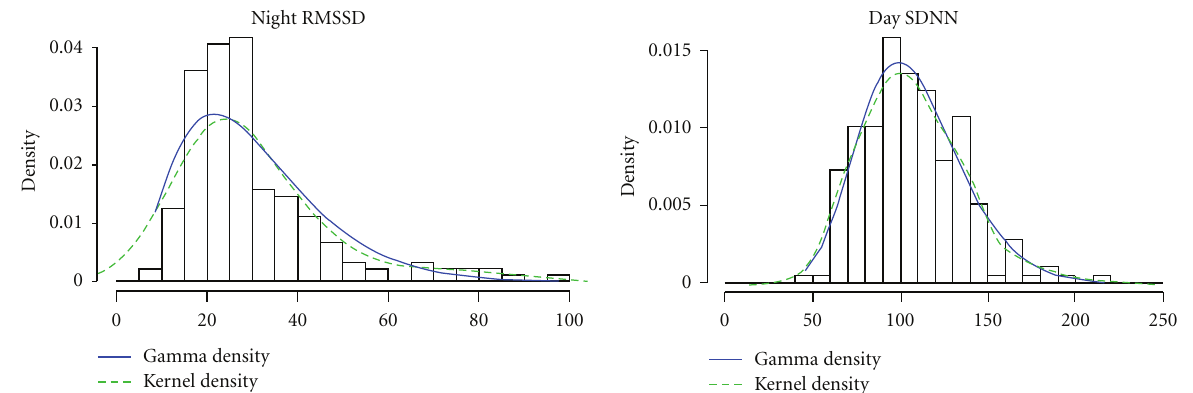
Figure 1: Histograms of heart rate variability variables with a smooth kernel density estimate (dashed line) and gamma distribution (solid line). RMSSD: root mean square of successive di ff erences; SDNN: standard deviation of N-N intervals.